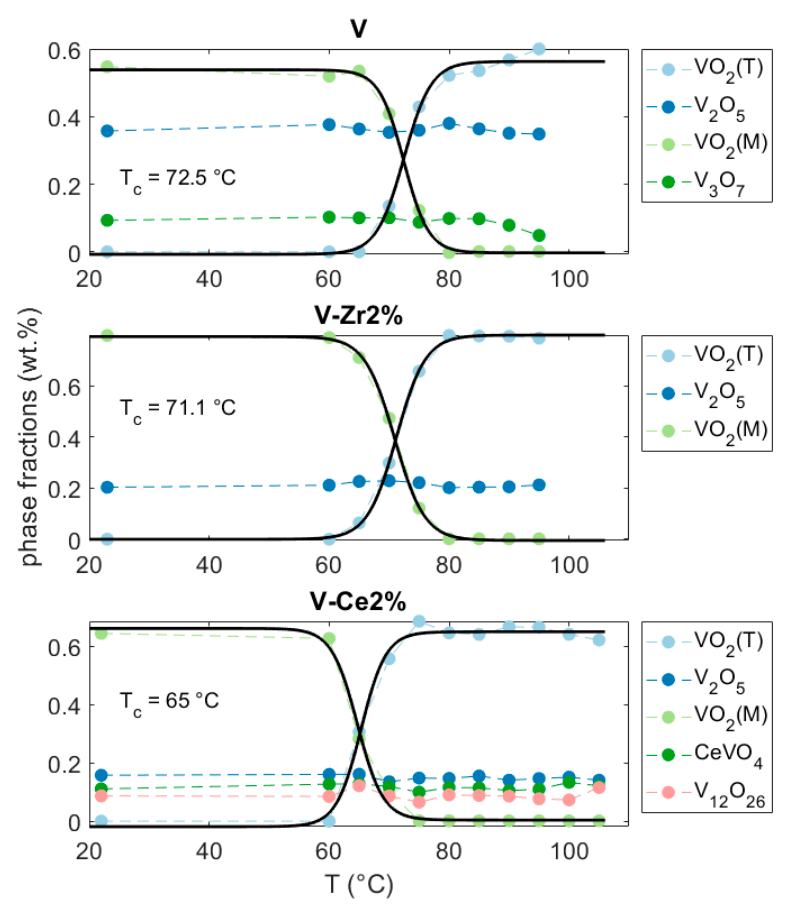
Figure 4. Rietveld-refined phase fractions for V, V-Zr2%, and V-Ce2% films. Solid lines represent the fitting curves as described in the text; fitted transition temperatures are reported as T c .